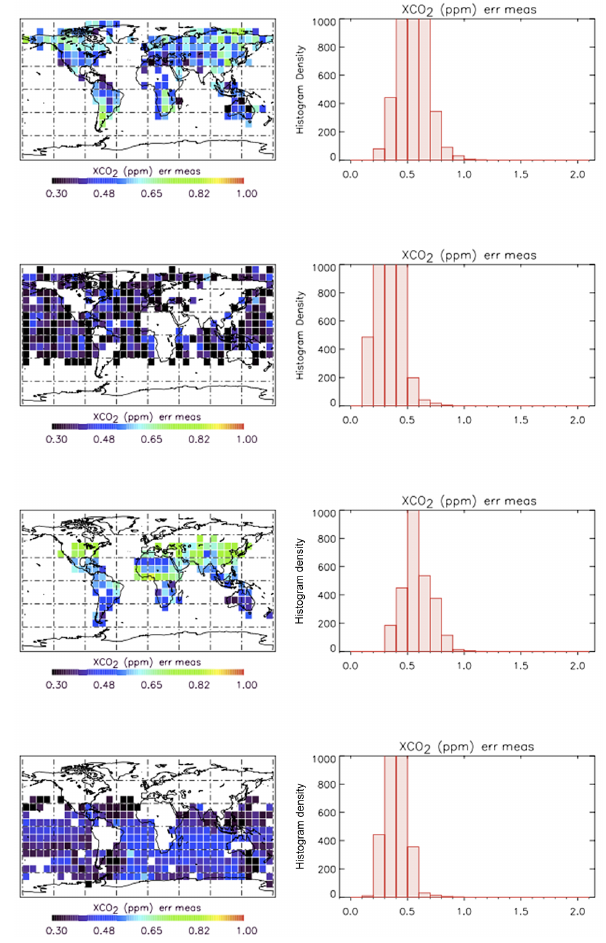
Figure 1. Measurement error. Top: June, land; second row: June, ocean; third row: Dec., land; bottom: Dec.,